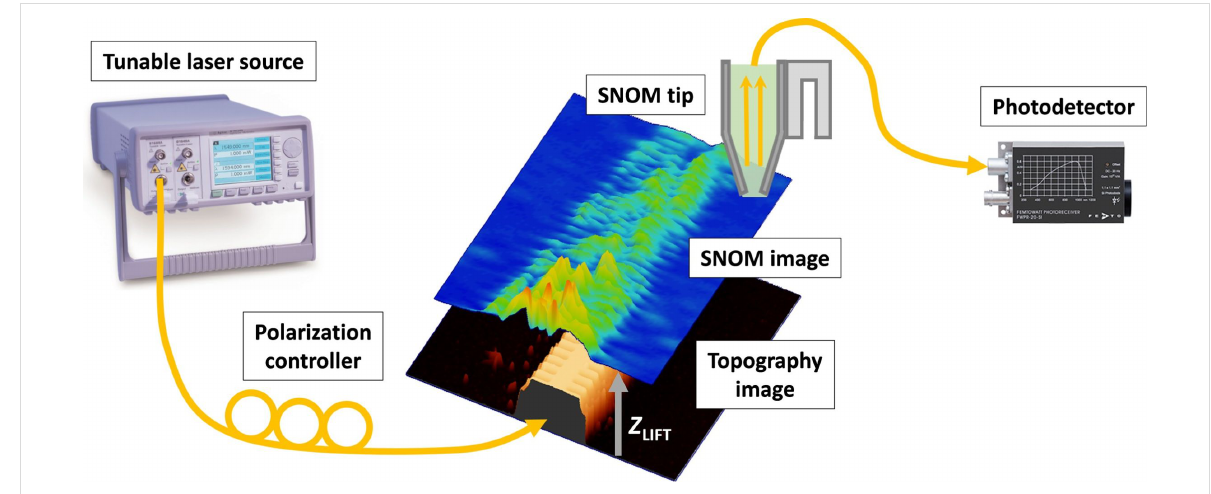
Figure 2: Schematic view of the SNOM characterization setup and measurement process.